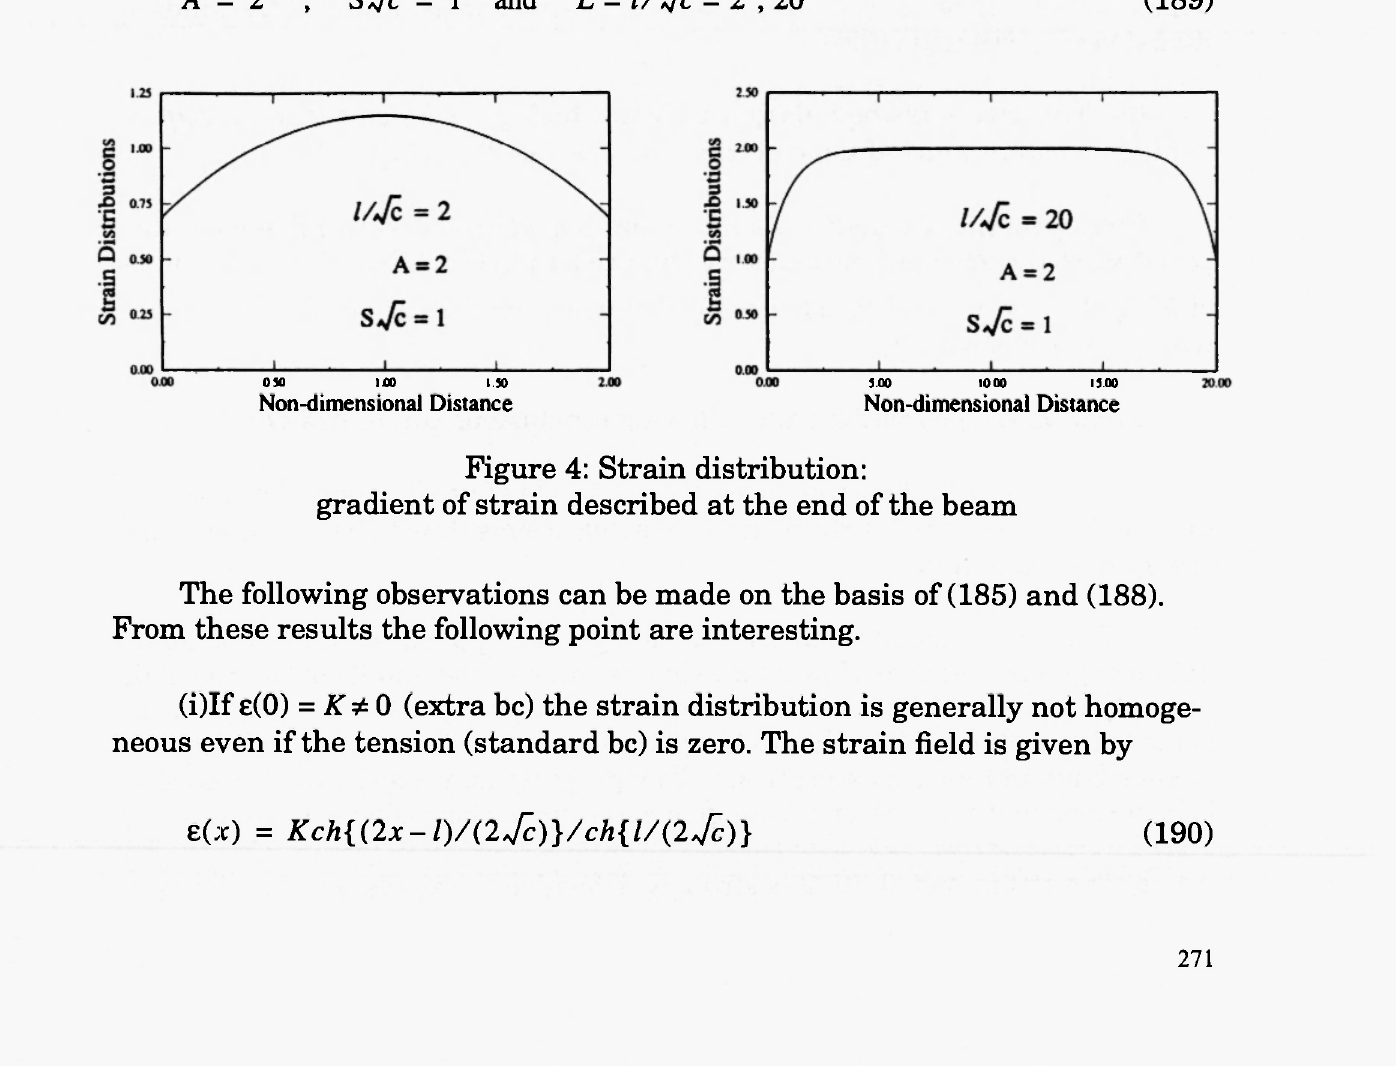
Figure 3: Strain distribution when the strain assigned at the ends of the bar